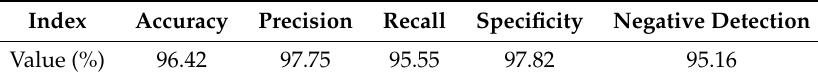
Table 23. Detection evaluation indices.